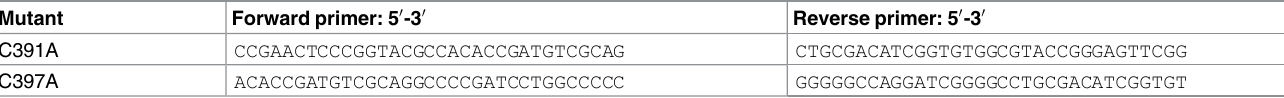
Table 1. Primer sequences used for site-directed mutagenesis of MTb Pck. Mutant Forward primer: 5 0 -3